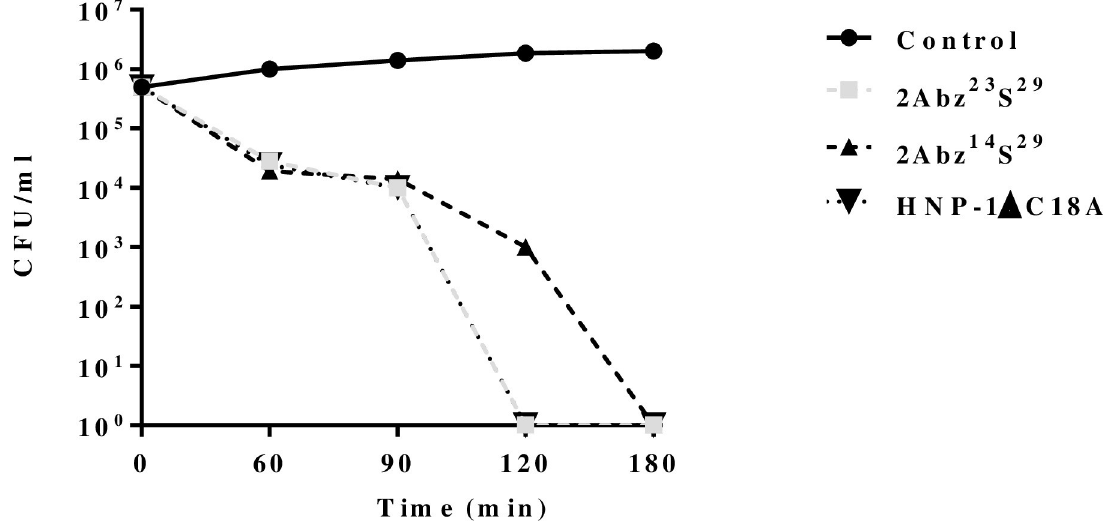
Fig 3. Killing kinetics of 2Abz 14 S 29 , 2Abz 23 S 29 , and HNP-1 Δ C18A against multidrug-resistant E . coli . Bacteria were incubated with the peptides at concentrations equal to their MICs for different times. Control represents untreated bacteria. Data are expressed as mean of at least two independent